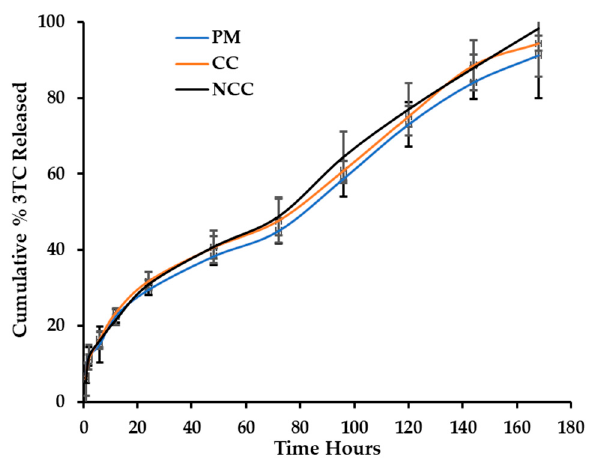
Figure 2. Cumulative percentage of lamivudine (3TC) released from a Pluronic ® F127 (PF-127) hydrogel loaded with 3TC in a physical mixture (PM), as a micro co-crystal (MCC) and nano co- crystal (NCC).